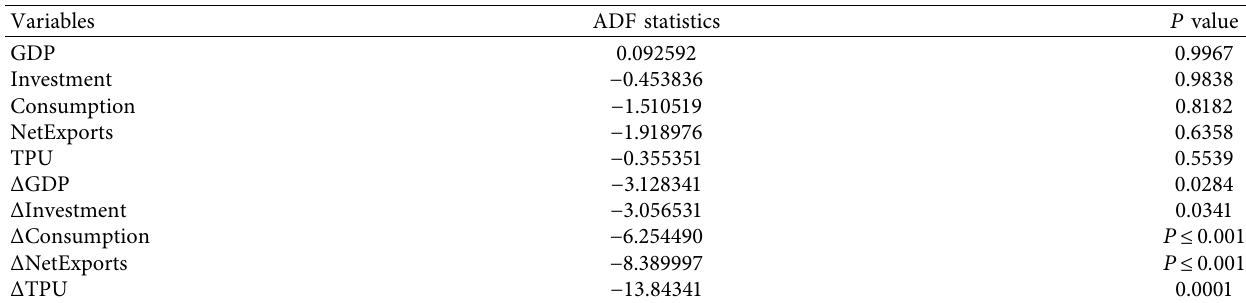
Table 2: ADF test results of each